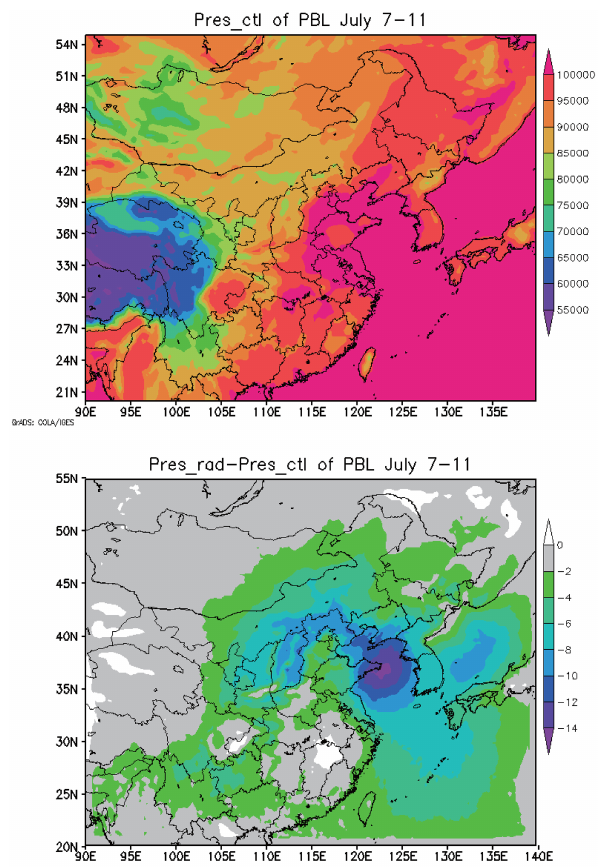
Figure 7. The PBL-averaged air pressure (hPa) from the CTL ex- periment (top) and its difference between the RAD and CTL exper- iments (bottom) of 7–11 July.